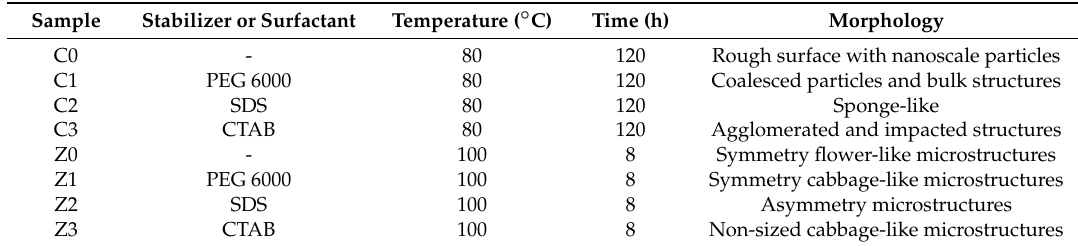
Table 1. Preparation conditions for all of the